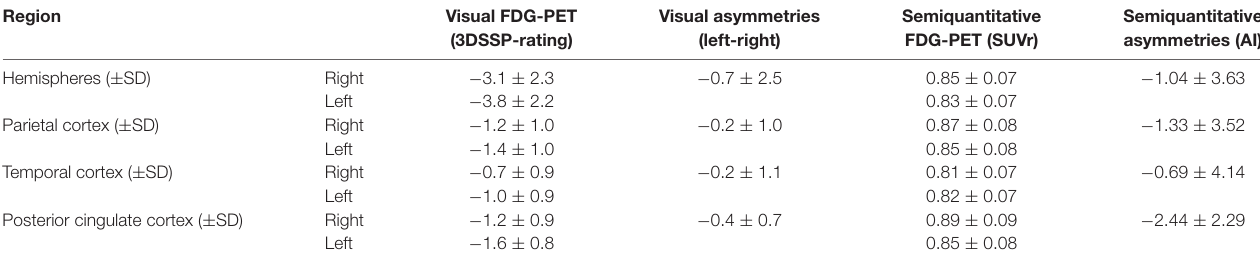
TABLE 2 | Visual and semiquantitative FDG-PET results and asymmetries. Region